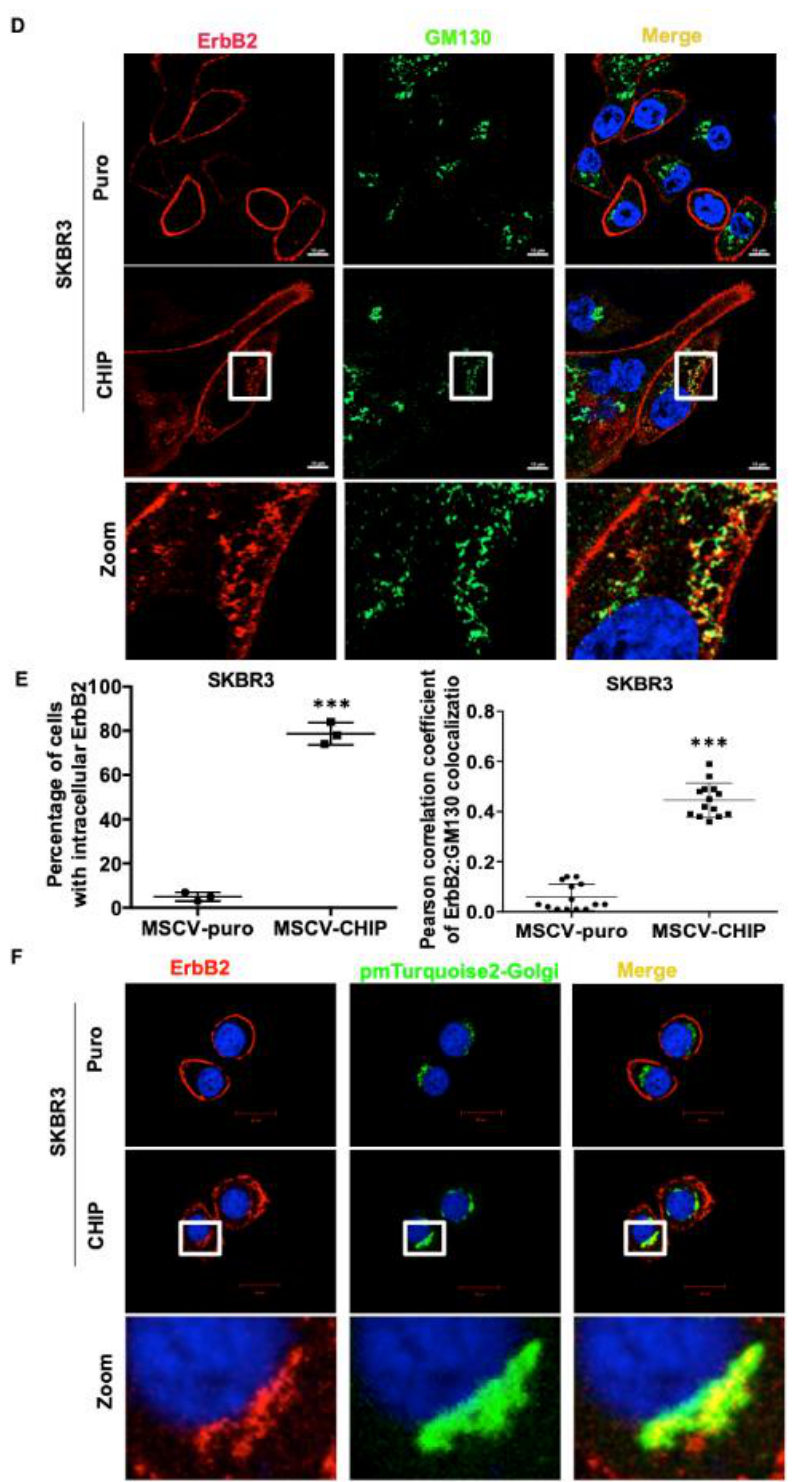
Figure 3. CHIP overexpression leads to increased ErbB2 retention in the Golgi. ( A ) 21MT1-puro and 21MT1-CHIP cell lines were seeded on glass coverslips for 48 h. Cells were fixed and stained with anti-ErbB2 (green) and anti-calnexin (ER marker) (red) antibodies followed by staining with the corresponding fluorescent secondary conjugates. Coverslips were mounted with anti-fade containing DAPI and images were acquired under a Zeiss LSM 710 confocal microscope. ( B ) 21MT1-puro and 21MT1-CHIP cell lines were seeded on coverslips, fixed, and stained with anti-ErbB2 (green)